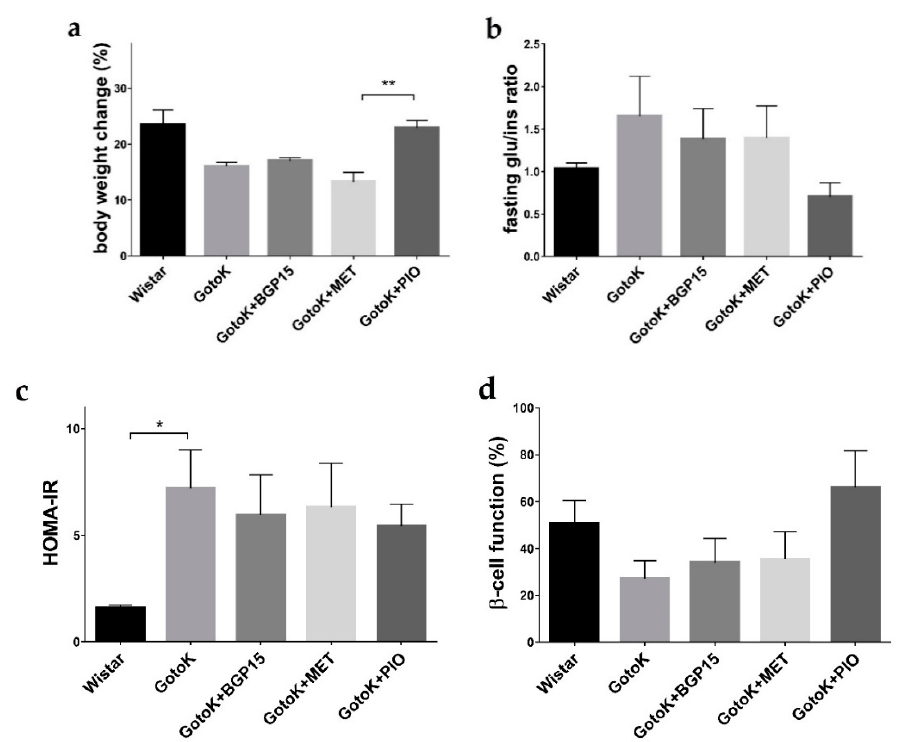
Figure 1. Metabolic parameters in control (Wistar) and diabetic (GotoK) rats treated with vehicle (GotoK), BGP-15 (GotoK + BGP15), metformin (GotoK + MET) and pioglitazone (GotoK + PIO). ( a ) calculated body weight gain in per cent; ( b ) calculated fasting glucose/insulin ratio; ( c ) calculated homeostasis model assessment-estimated insulin resistance (HOMA-IR) index; ( d ) calculated HOMA-B index. Values are presented as mean ± SEM; asterisks (*) denotes significance (Kruskal-Wallis test with Dunn’s post-test, n = 6/group, * p < 0.05; ** p < 0.01).